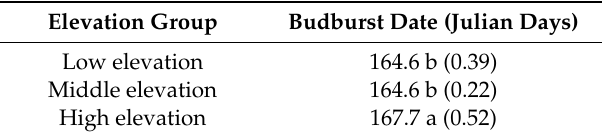
Table 4. Mean budburst for each elevation group, with standard errors in parentheses. Means followed by the same letter do not di ff er significantly ( p ≤ 0.05; Tukey’s honestly significant di ff erence (HSD) tests; provenance main e ff ect p = 0.0026).